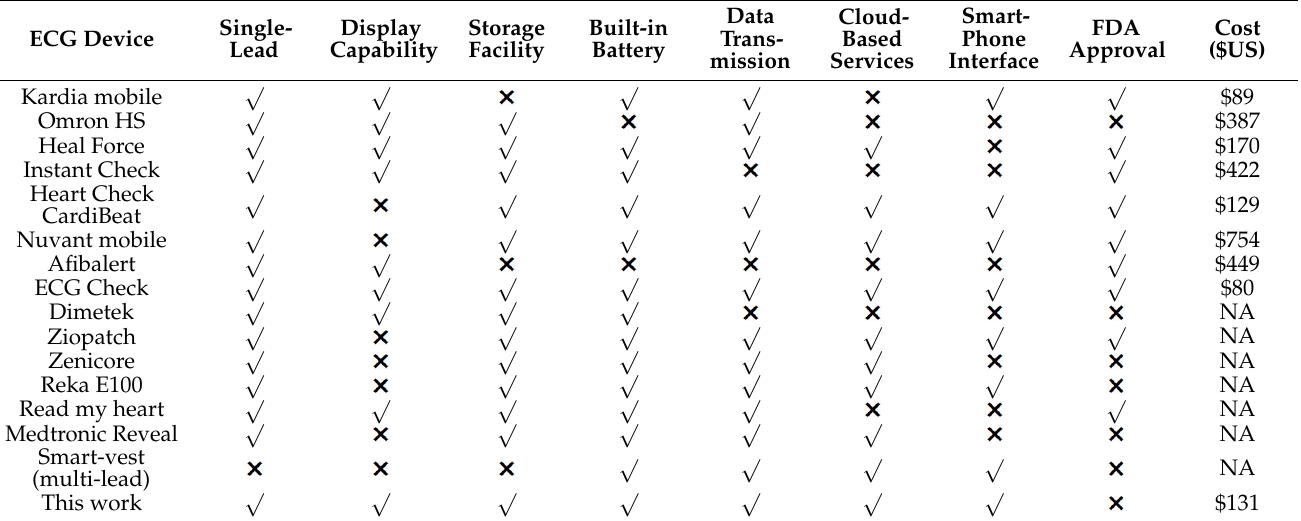
Table 1. Comparison of commercially available ECG capturing systems ( available, while means that the feature is